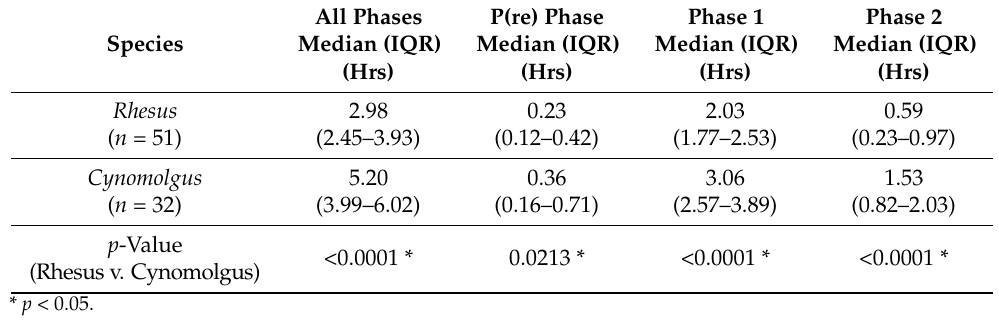
Table 3. Training Time Summary by Species.